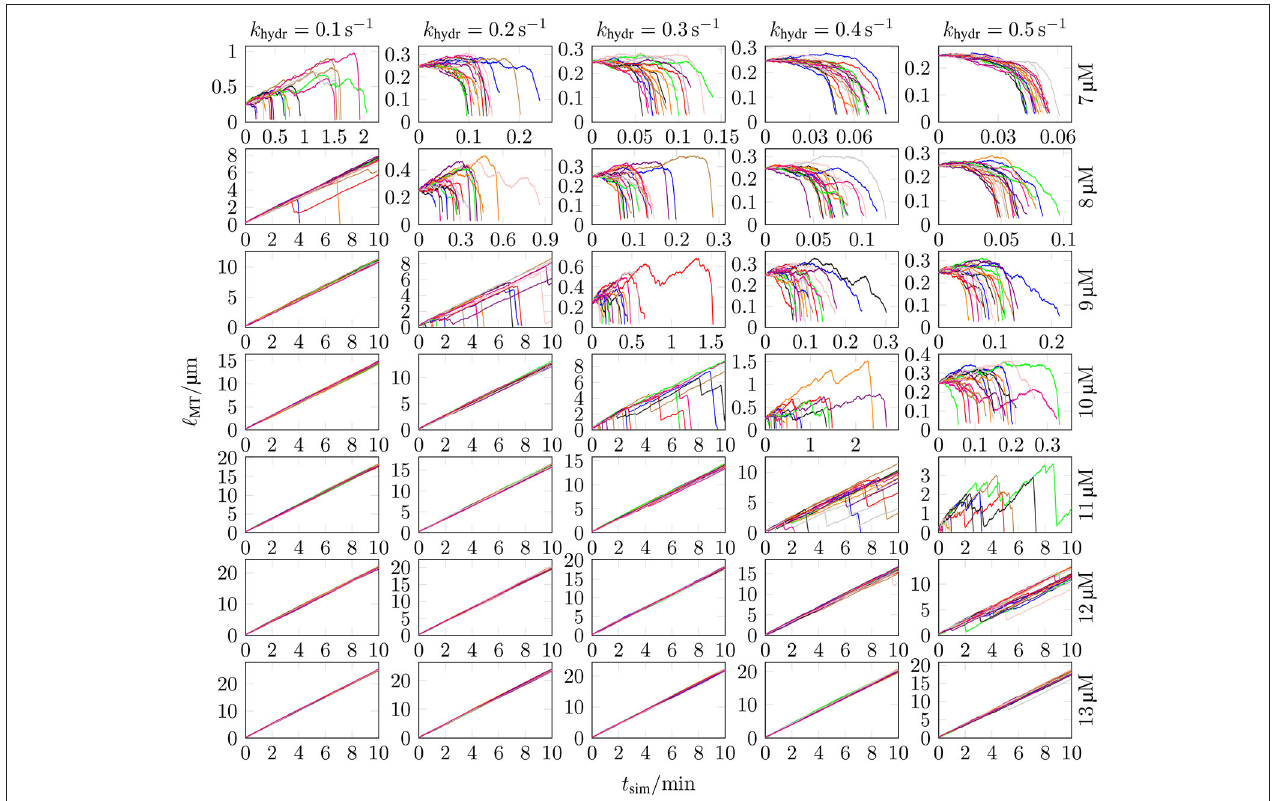
FIGURE 7 | The MT length ℓ MT was measured as a function of the simulation time t sim for 20 different simulations with k + = 4 µ M − 1 s − 1 , 1 G 0 ∗ long = − 9.3 k B T , k lat = 100 k B T / nm 2 , seven different values of c tub , and five different values of k hydr . MT growth trajectories for three additional c tub values can be found in Figure S9 in the Supplementary